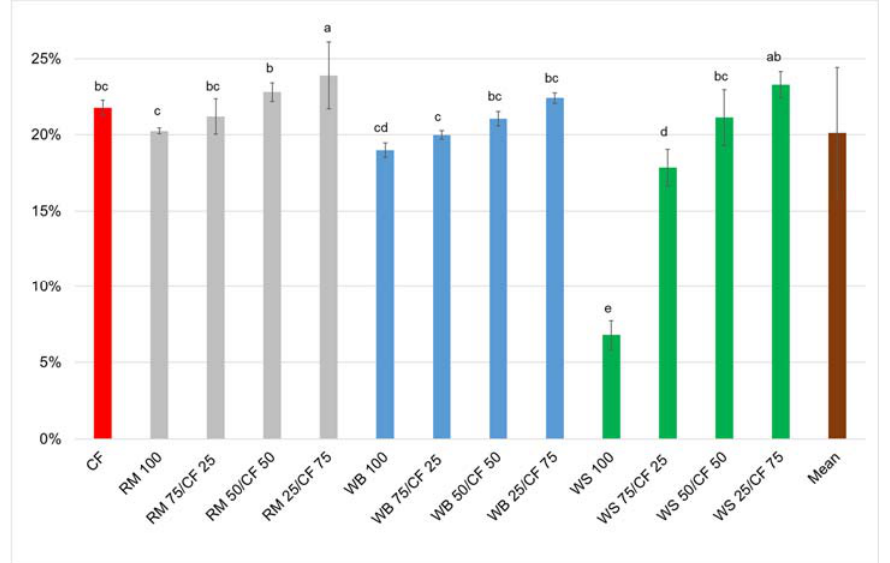
Figure 5. Efficiency of Conversion of Ingested feed (ECI) depending on the type of feed, results on a dry basis; CF (chicken feed), RM (rapeseed meal), WB (wheat bran) and WS (willowleaf sunflower); a, b, c… ‐ letters mean that the values are statistically different (Tukey’s test at P < 0.05).